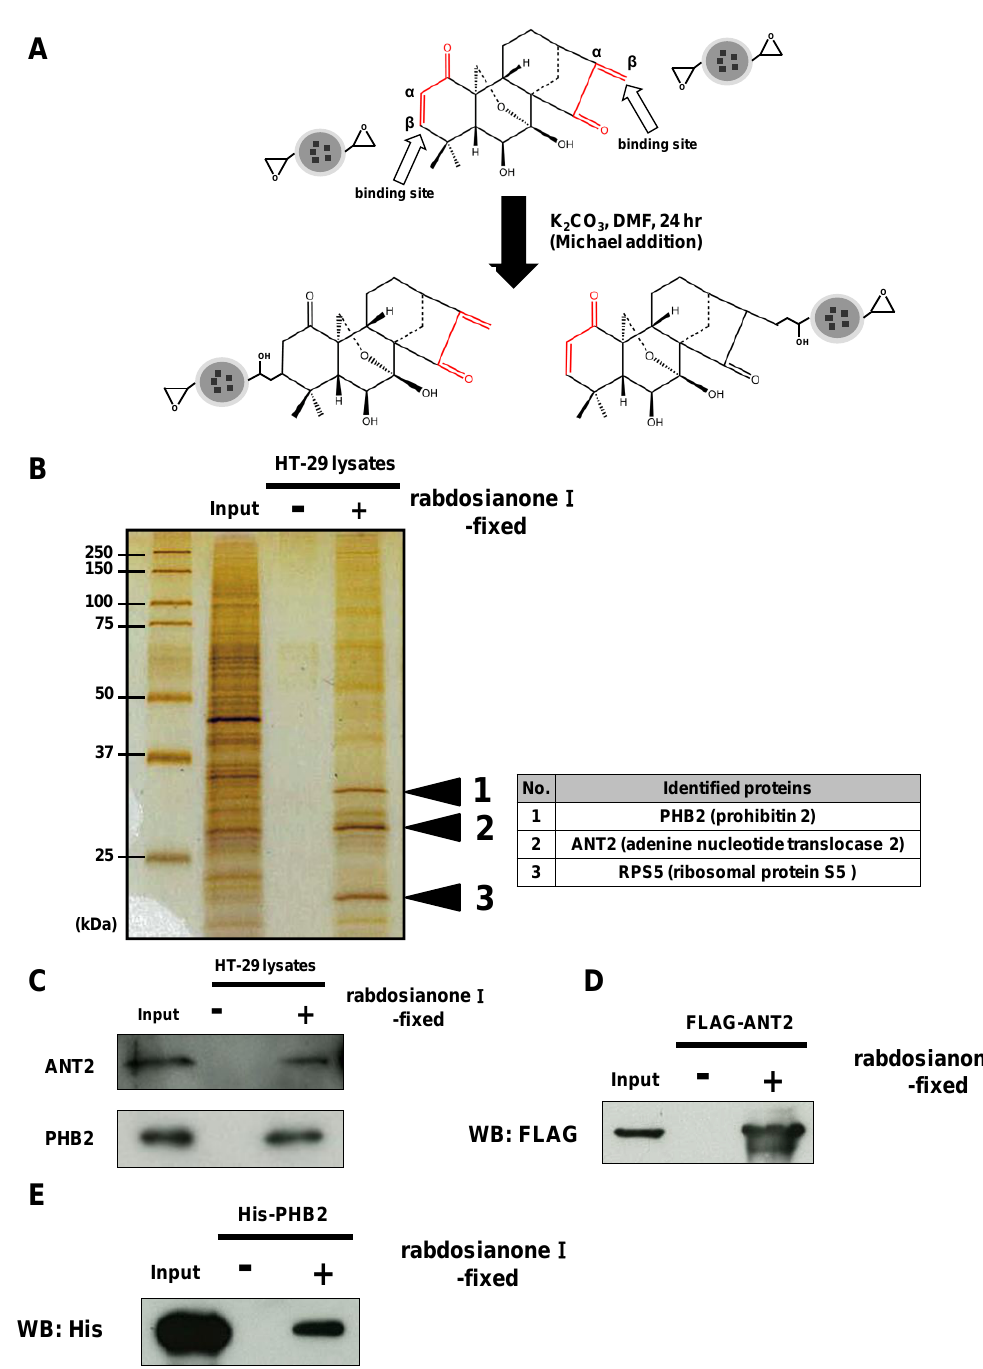
Figure 3. Rabdosianone I directly binds to ANT2 and PHB2. ( A ) Scheme of fixation of rabdosianone I onto magnetic FG beads and the two predicted structures of rabdosianone I-fixed beads. α, β-Unsaturated ketones are shown by the red lines. ( B ) Identification of rabdosianone I-binding proteins. Three rabdosianone I-binding proteins were purified from whole-cell extracts of HT-29 cells with rabdosianone I-fixed FG beads and detected by silver staining. Mass spectrometry analysis identified three rabdosianone I-binding proteins, as shown in the right table. ( C ) Confirmation of the interaction of rabdosianone I with ANT2 and PHB2. Bound ANT2 and PHB2 were detected by Western blotting with either anti-ANT2 or PHB2 antibody. ( D ) Confirmation of the interaction of rabdosianone I with recombinant ANT2. Purified recombinant FLAG-ANT2 was incubated with rabdosianone I-fixed FG beads, and bound FLAG-ANT2 was detected by Western blotting with the anti-FLAG antibody. ( E ) Confirmation of the interaction of rabdosianone I with recombinant PHB2. Purified recombinant His-PHB2 was incubated with rabdosianone I-fixed FG beads, and bound His-PHB2 was detected by Western blotting with the anti-His antibody.